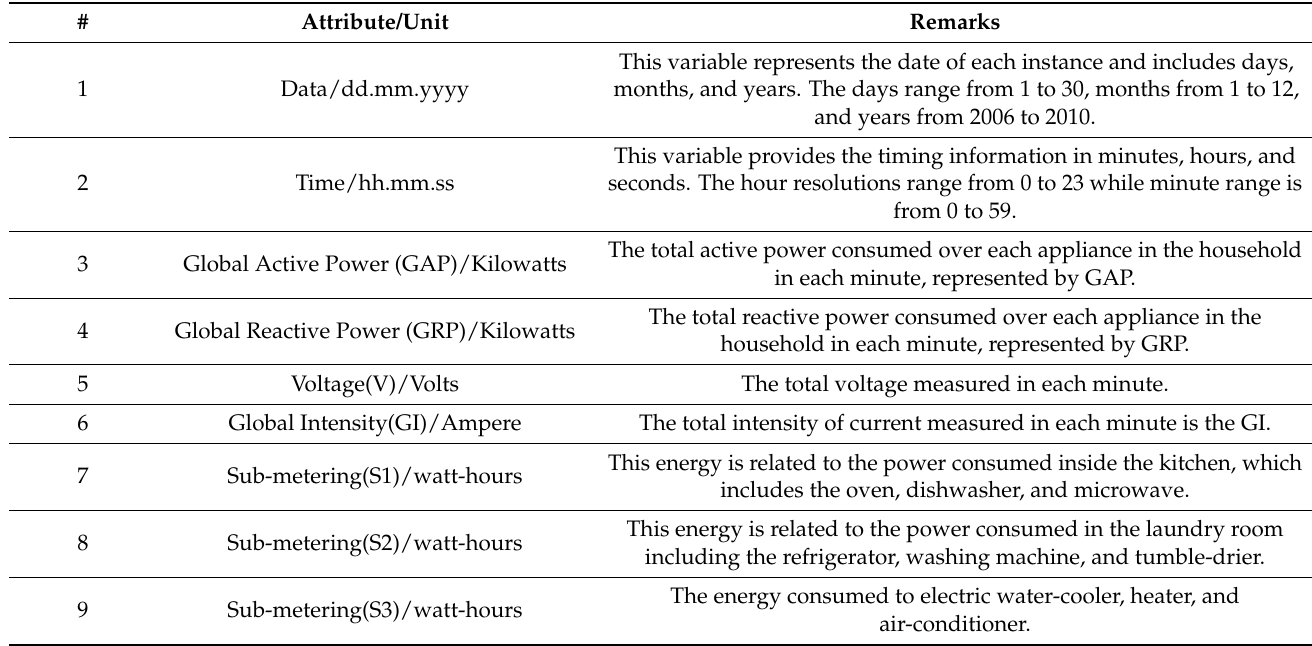
Table 5. Detailed description of each attribute in the dataset including units and remarks.